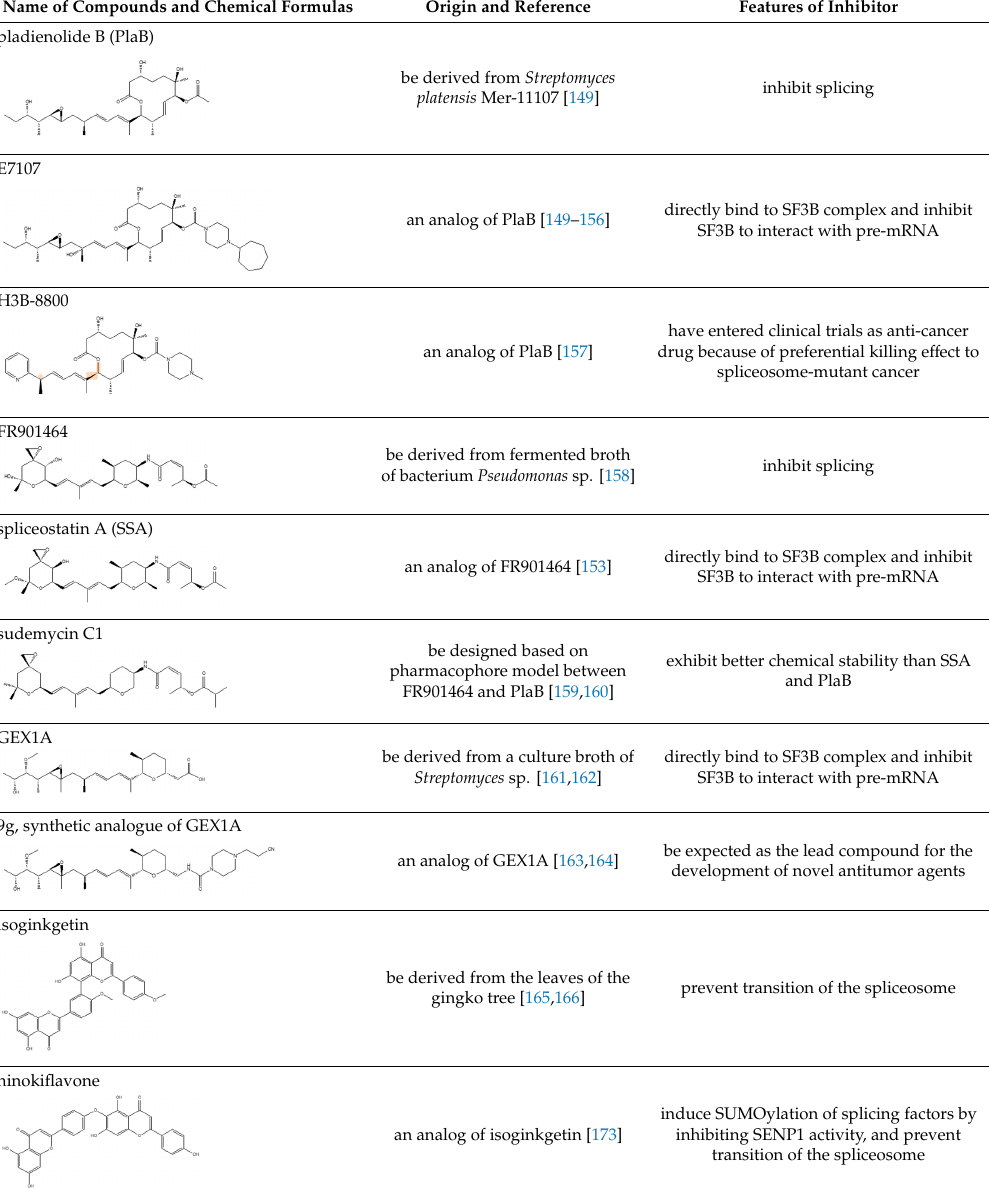
Table 1. Chemical compounds which control splicing.